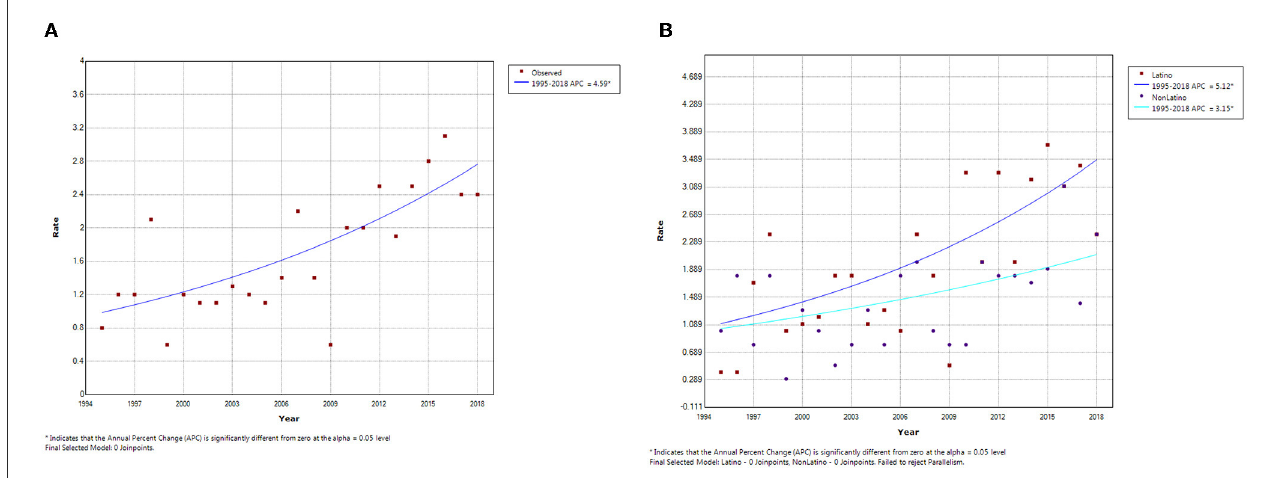
FIGURE1 Joinpoint analysis of hepatoblastoma incidence trends in Texas, (A) Overall and (B) by Ethnicity, 1995–2018.